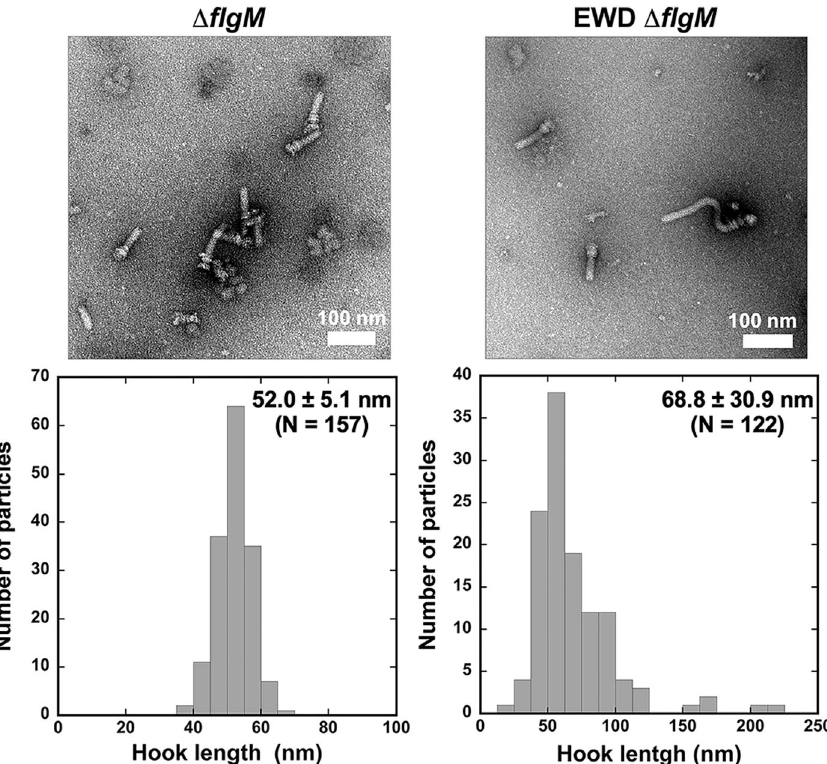
Fig. 4 Effect of the fl hA EWD mutation on hook length. Electron micrographs of HBBs and histograms of hook length distribution of NH001gM carrying pMM130 ( Δ fl gM ) or pYI003 (EWD Δ fl gM ).